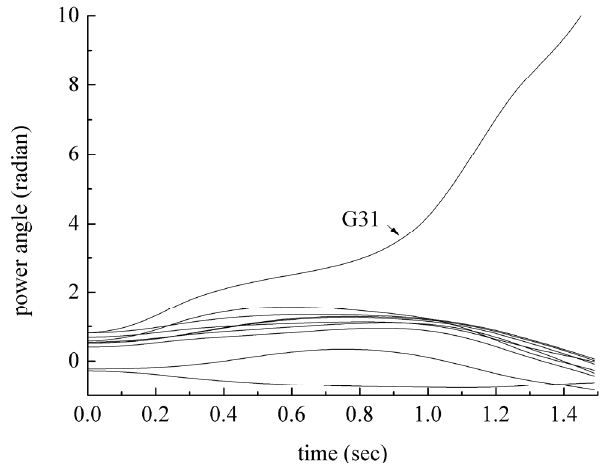
Figure 7. Multi-machine swing curves after Figure 7. Multi ‐ machine swing curves after fault